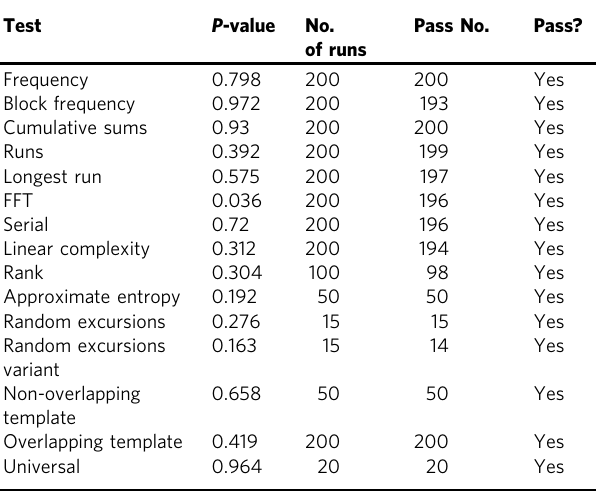
Table 1 National Institute of Standards and Technology (NIST)